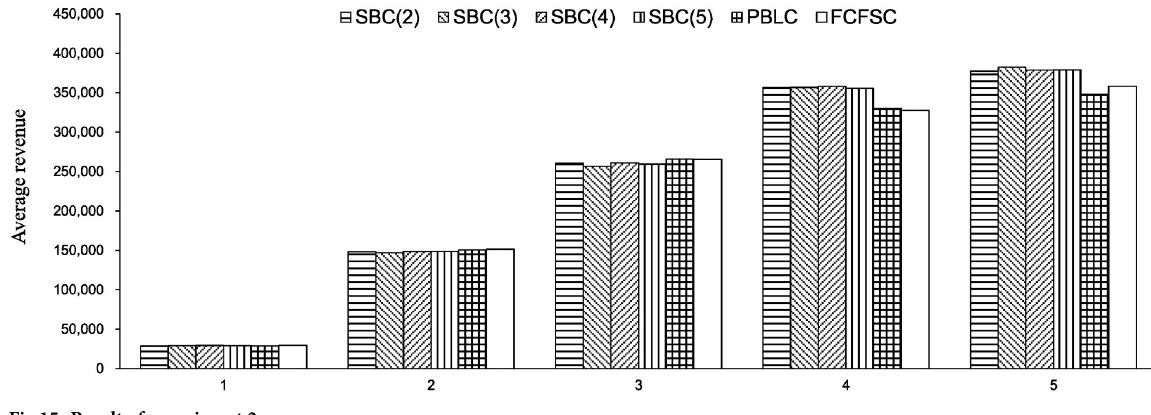
Fig 15. Result of experiment